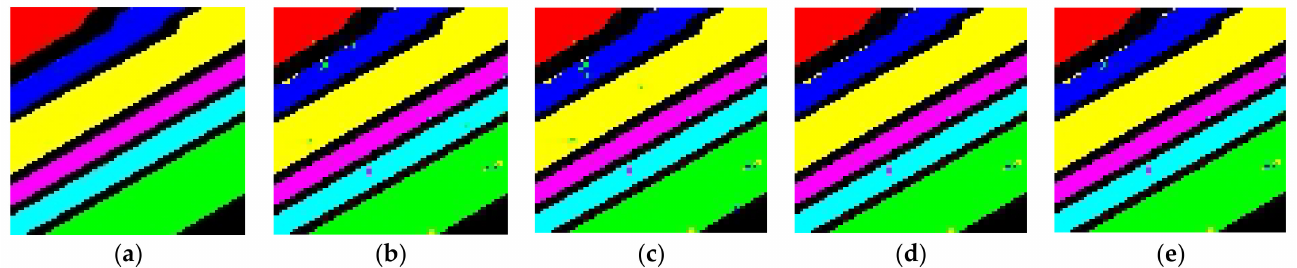
Figure 5. Salinas-A hyperspectral image classification result image. ( a ) (ground truth), ( b ) SVM, ( c ) TWSVM, ( d ) AENSVM, ( e )